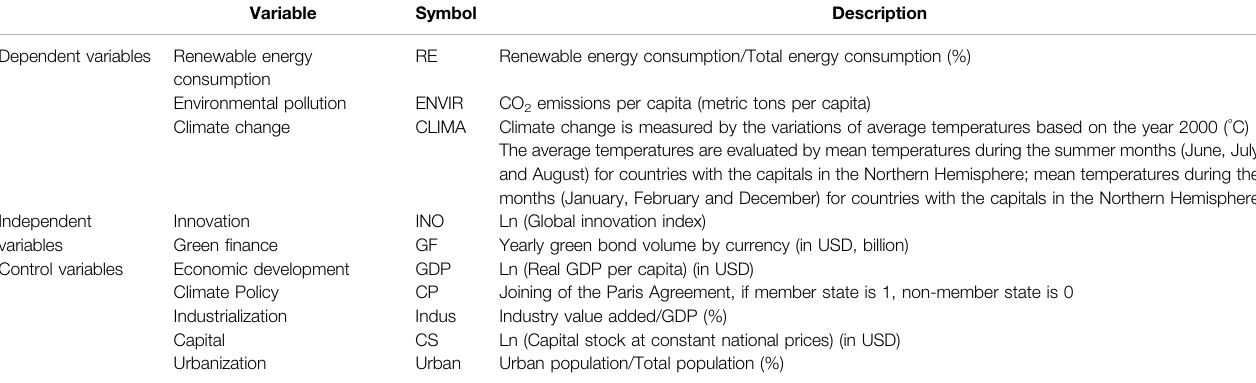
TABLE 2 | Variables description.